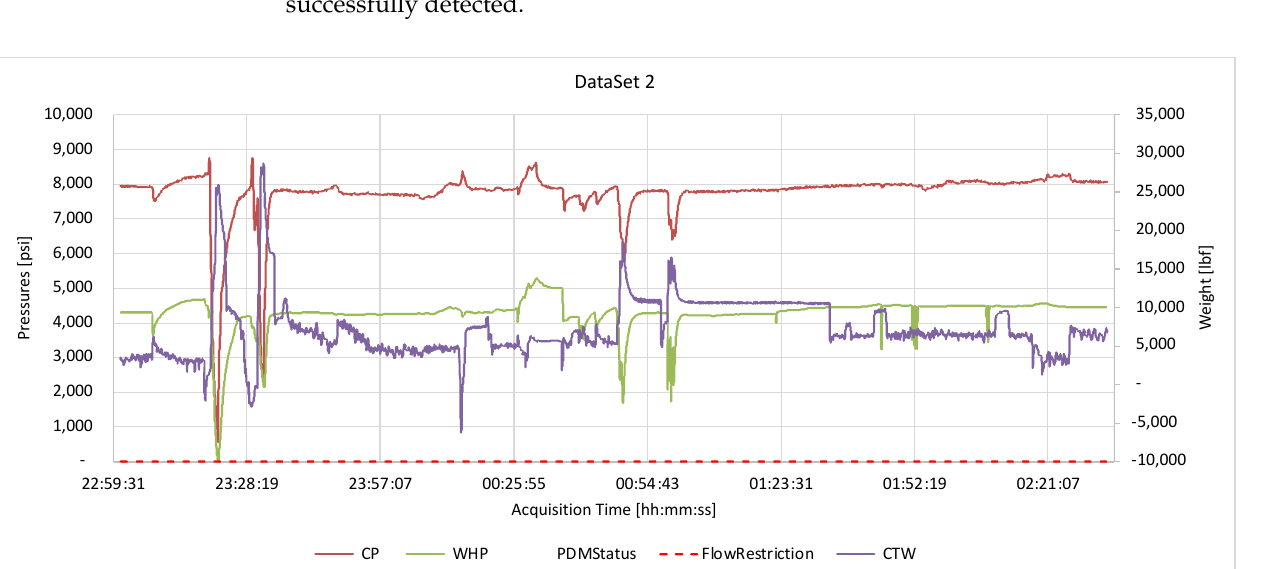
In Dataset 2 (Figure 11), all the stall points at 23:19, 23:29, and 00:15 were successfully detected.